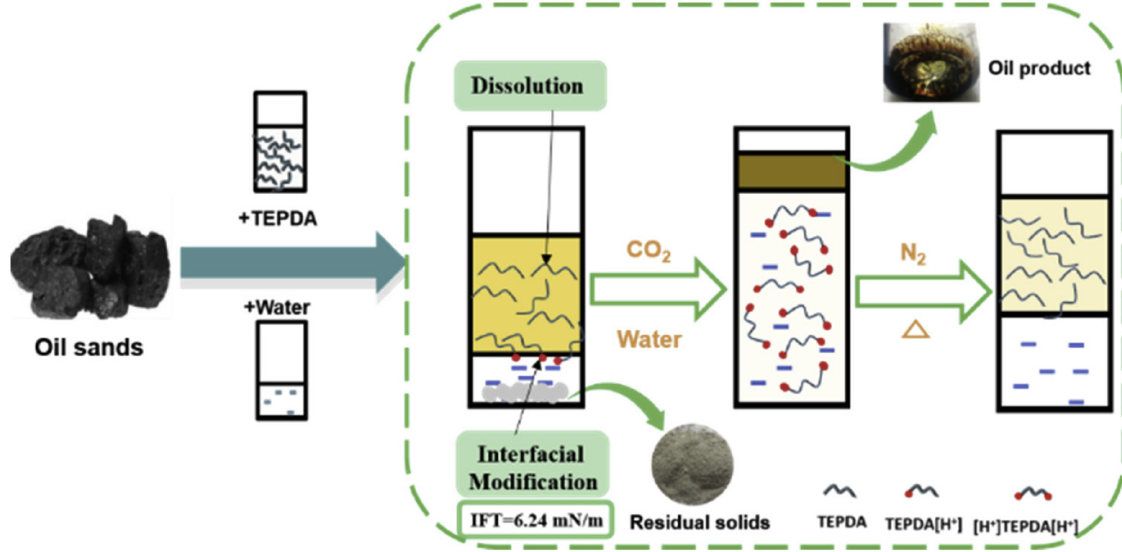
Figure 33. The schematics of the SHS–water hybrid process in separating bitumen from Indonesia carbonate asphalt rocks. Reprinted with permission from Ref. [219]. Copyright 2019, copyright the Elsevier. More details on Copyright and Liscensing are available via the following link: https://www.sciencedirect.com/.